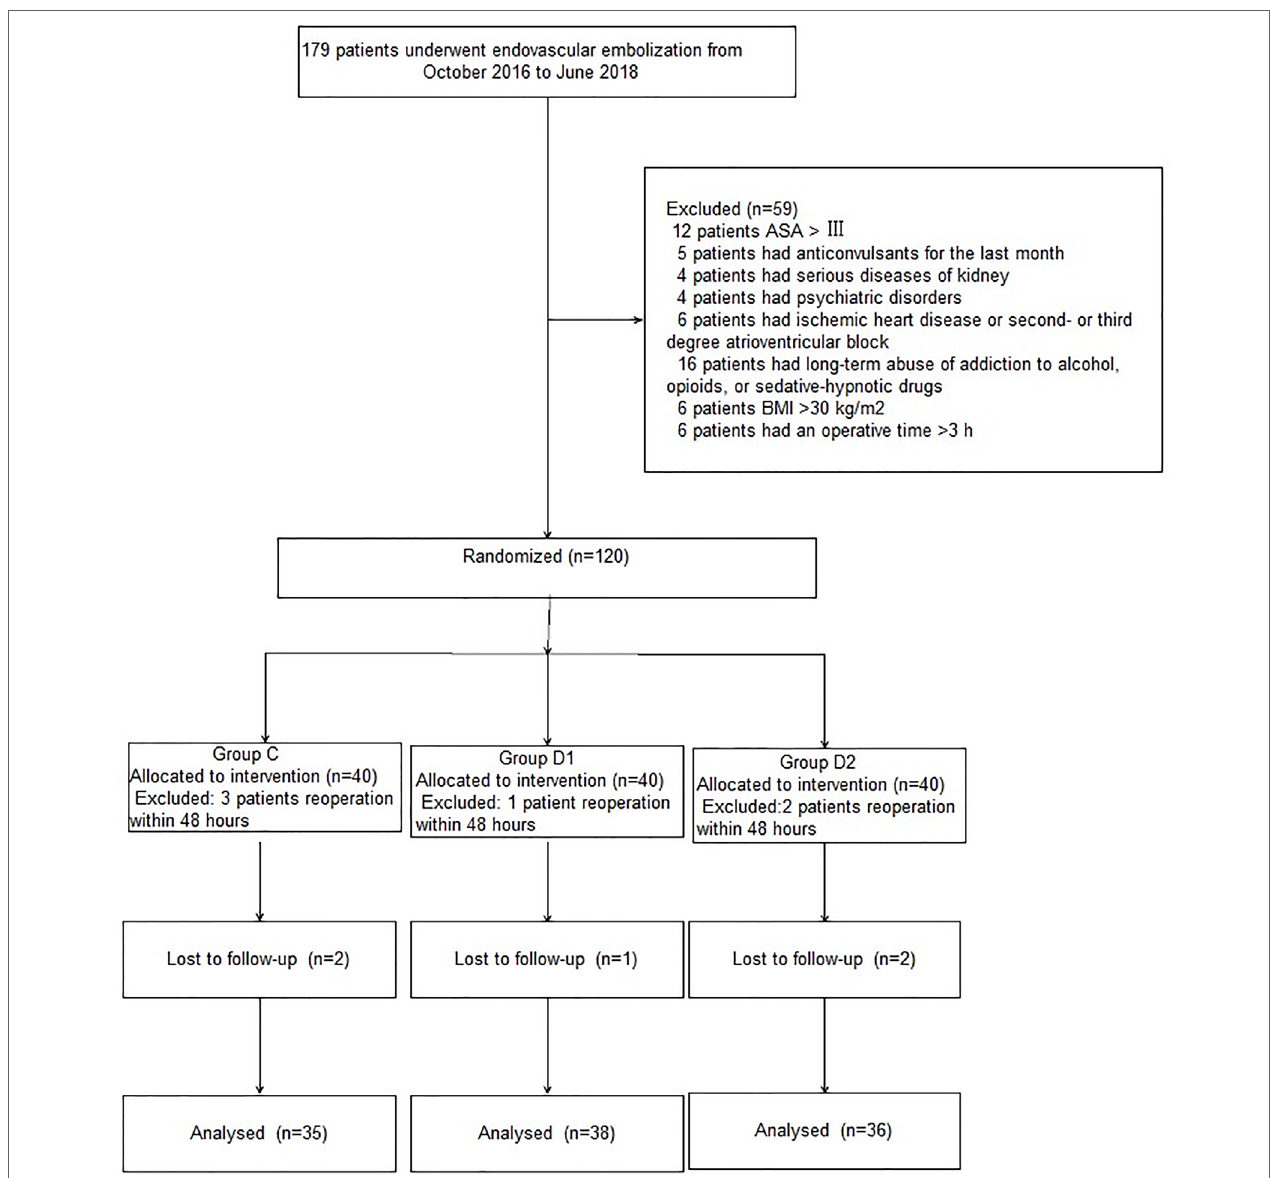
FIGURE 1 | Patients enrollment flow